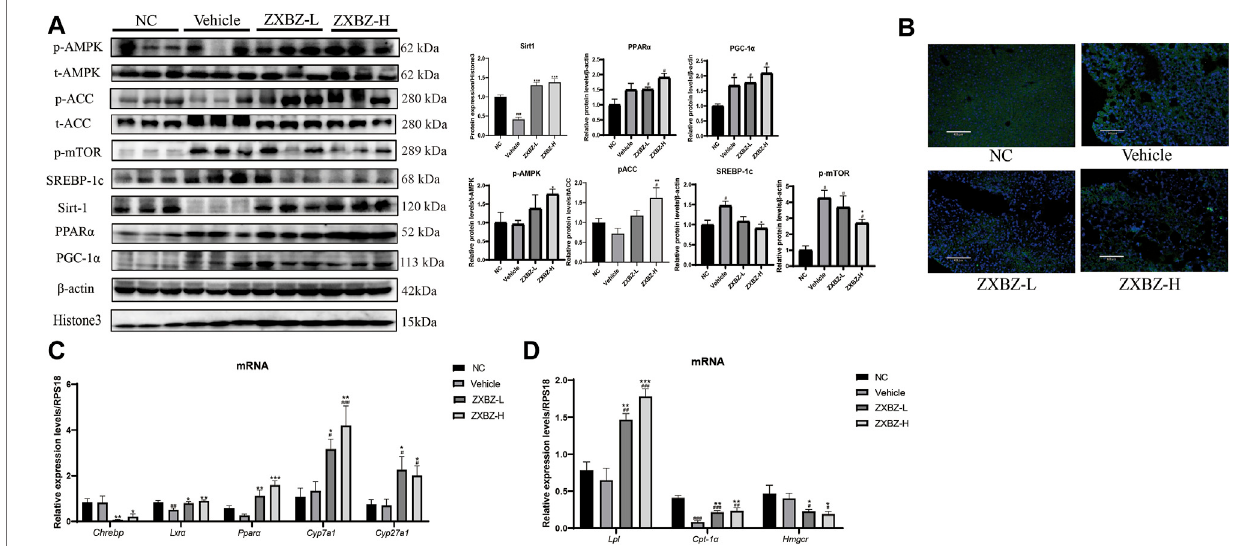
FIGURE 6 | ZXBZ decoction could in fl uence lipid metabolism – related proteins in Sirt1 and AMPK pathway. (A) Western blotting and related quanti fi cation of NC, vehicle, ZXBZ-L, and ZXBZ-H group. Data are mean ± SEM ( n = 3 per group). (B) Immuno fl uorescence of FASN. Blue represented cell nucleus, and green represented FASN in the cytoplasm. (C,D) mRNA levels ofgenesdetermined by qRT-PCR. The data are the mean ± SEM ( n = 6per group). # p < 0.05, ## p < 0.01 compared to NC. * p < 0.05, ** p < 0.01 compared to vehicle.